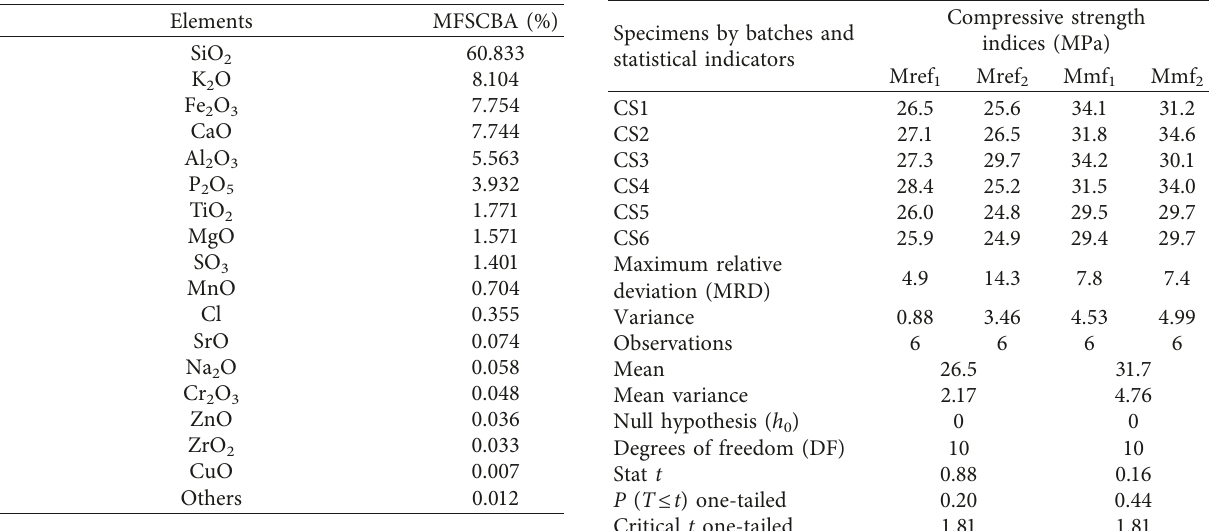
Table 3: Axial compressive strength and statistical indicators of